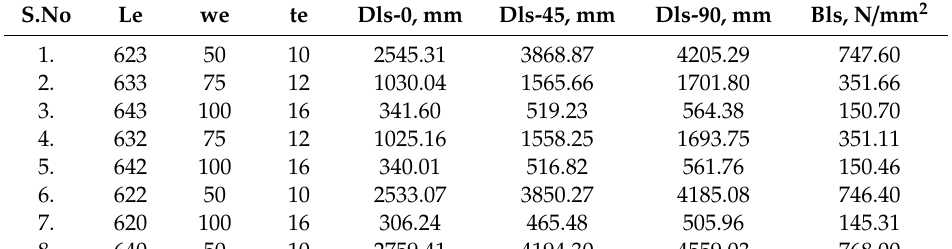
Figure 13. Comparison of deflection with different fiber orientation. Table 6. Maximum deflection of different carbon PEEK fiber orientations.